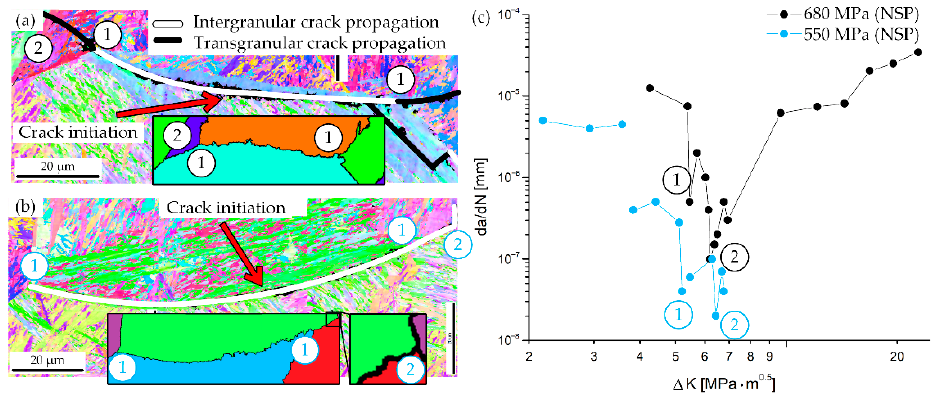
Figure 10. EBSD analysis and reconstructed prior austenite grain boundaries of ( a ) an NSP sample, after 155,000 cycles at Δσ /2 = 680 MPa, and ( b ) an NSP sample, loaded after 1,000,000 cycles at Δσ /2 = 550 MPa; ( c ) crack propagation rate as a function of the stress intensity factor. The numbers in the EBSD analysis and the crack propagation curve mark the breakpoints of the cracks.